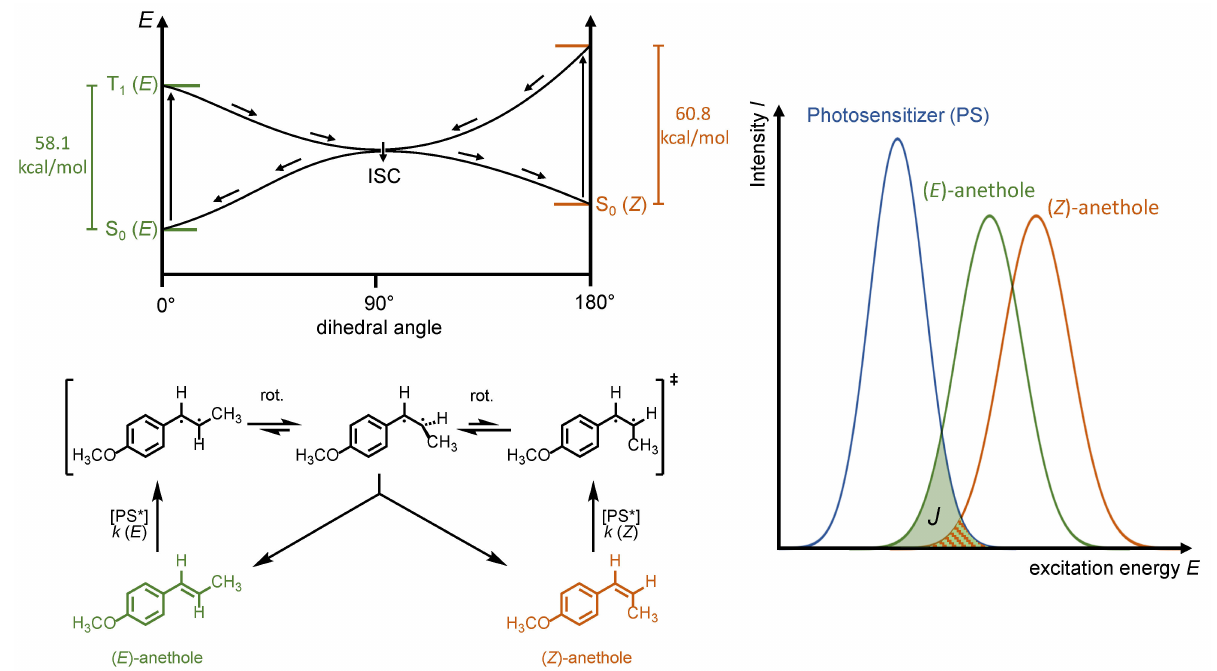
Figure 2. ( A ) Mechanism of ( E )- to ( Z )-isomerization of anethole. By energy transfer of the excited photosensitizer (PS*), ( E )-anethole is excited to the T 1 state and reaches the global energy minimum by rotation about the former C=C double bond. Intersystem crossing (ISC) leads to the global maximum of the S 0 state. Relaxation can now occur either to ( E )- or ( Z )-anethole. The backwards reaction from ( Z )- to ( E )-anethole occurs analogously. ( B ) The ratio of ( E )-anethole: ( Z )-anethole in the photostationary state is dependent on the ratio of spectral overlap ( J ) of photosensitizer with ( E )-anethole (green area + green/orange striped area) to overlap of photosensitizer with ( Z )-anethole (green/orange striped